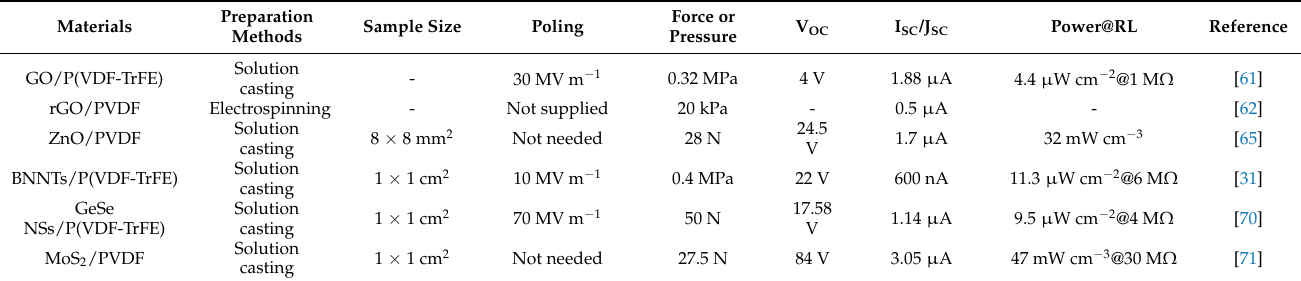
Table 3. Performances of the PVDF-based PENGs doped with semiconductor piezoelectric materials.